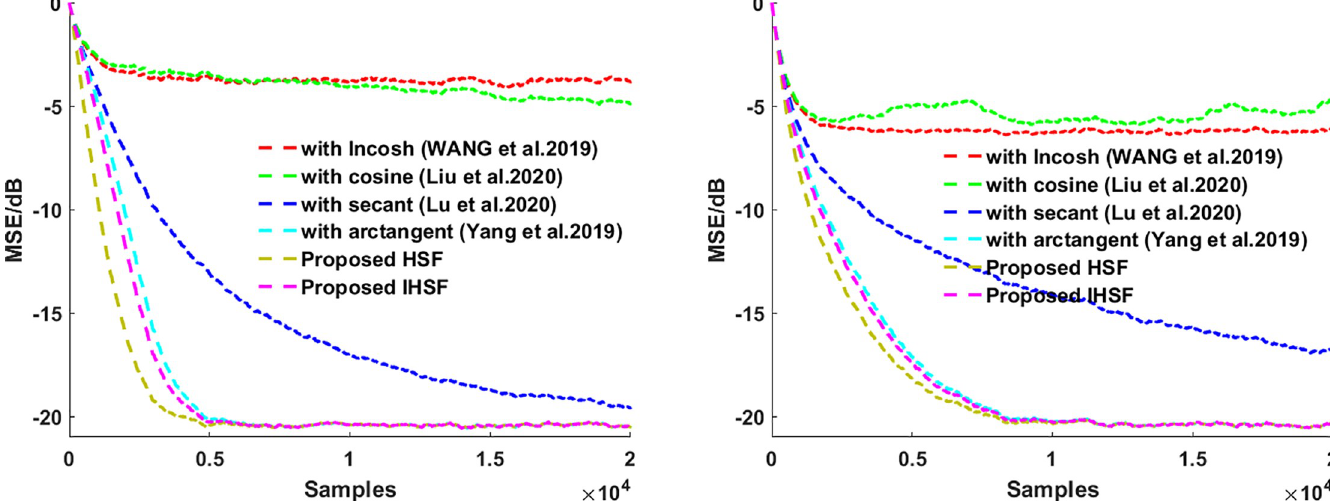
Fig 3. MSEs for the adaptive filtering algorithms by using hyperbolic functions. (left) with the uncorrelated input signal X UC ( n ); (right) with the correlated input signal X C ( n